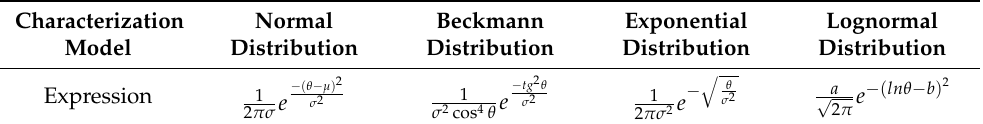
Table 5. Parameters of the lognormal distribution characterization